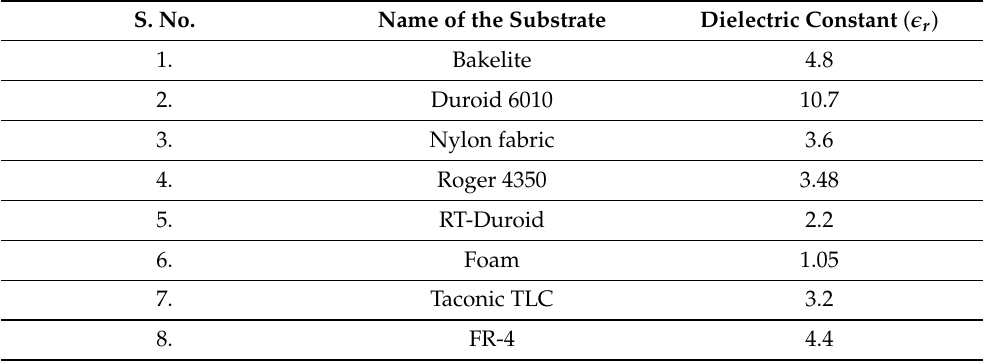
Table 1. Commonly used substrate materials in fractal